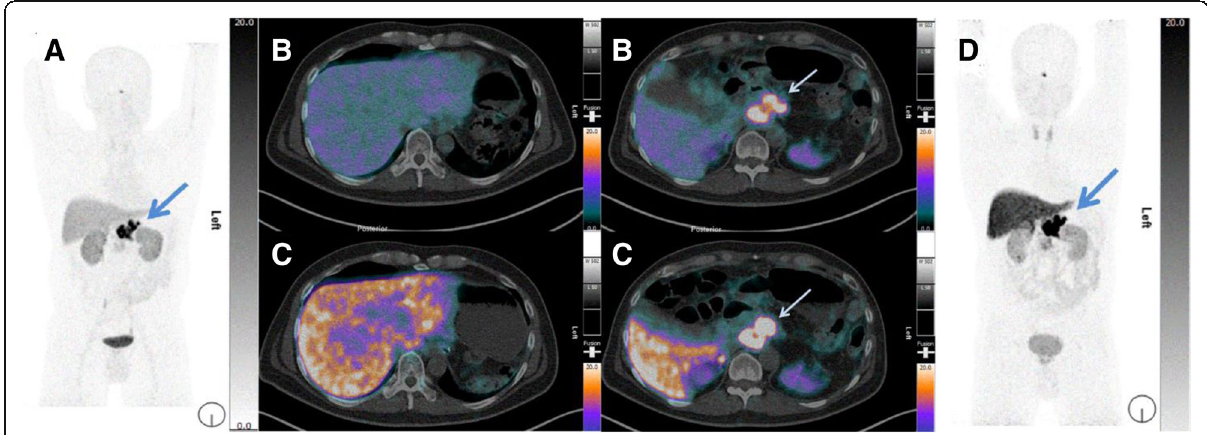
Fig. 6 [ 68 Ga]Ga-DATA-TOC and [ 68 Ga] Ga-DOTATOC PET/CT images. a [ 68 Ga]Ga-DATA-TOC PET MIP. b Transverse PET/CT fusion of [ 68 Ga]Ga-DATA- TOC PET/CT images. c Transverse PET/CT fusion [ 68 Ga]Ga-DOTA-TOC PET/CT images. d [ 68 Ga]Ga-DOTA-TOC PET MIP. Arrows indicate high uptake in the primary pancreatic NET. The [ 68 Ga]Ga-DATA-TOC PET/CT images show slightly higher physiological uptake in the kidneys as compared to the [ 68 Ga]Ga-DOTA-TOC PET/CT study in the same patient. There is significantly higher uptake in normal liver after injection of [ 68 Ga]Ga-DOTA- TOC in comparison with PET/CT images obtained after using [ 68